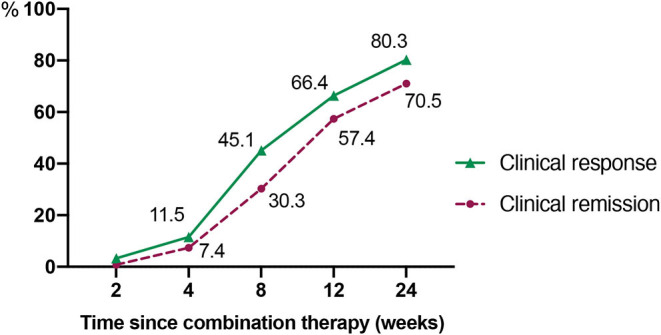
This figure shows the clinical remission and response rates over time.